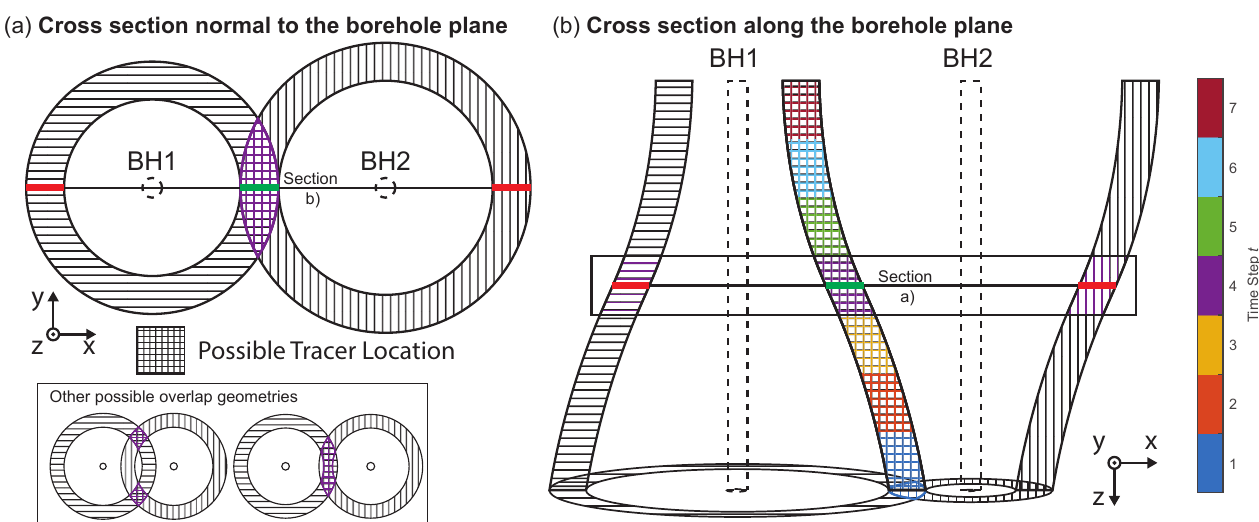
Figure 3. Method to reconstruct tracer flow path. Reflections can arise from positions radially symmetric to the borehole axis. Two boreholes allow to find intersections and constrain the location of the tracer, indicated by the squared pattern. ( a ) Cross section normal to the borehole plane. ( b ) Cross section within the borehole plane at time step t = 4. The colors indicate reflections identified during the associated time steps t